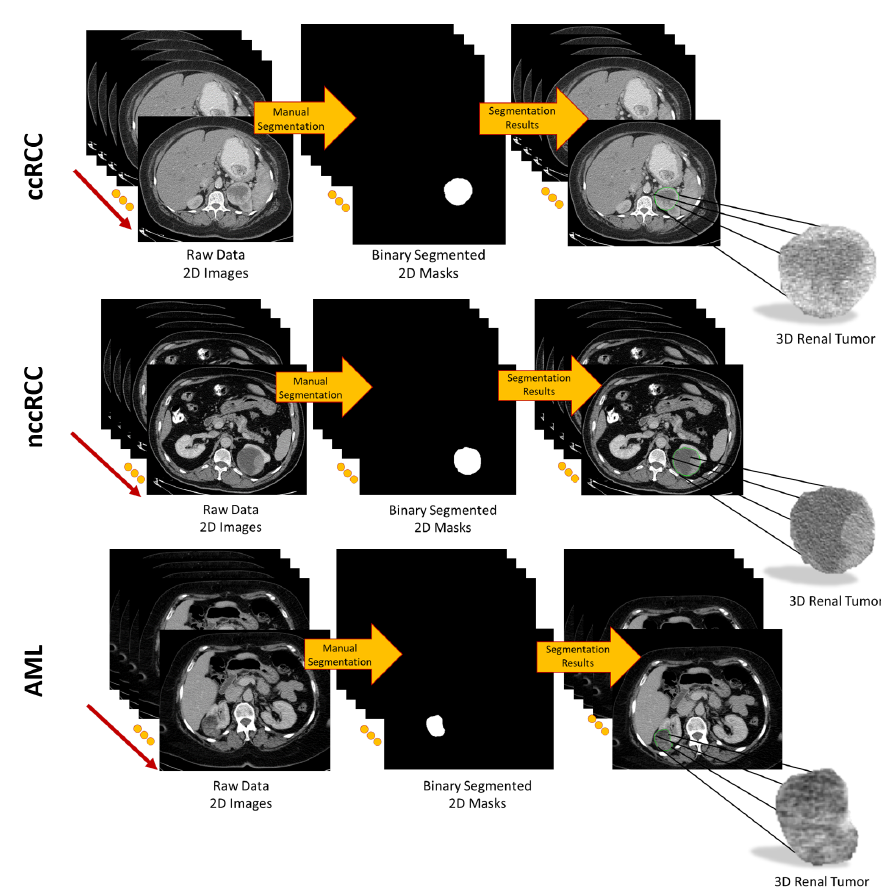
Figure 2. Visualization of the segmentation process to obtain 3D renal